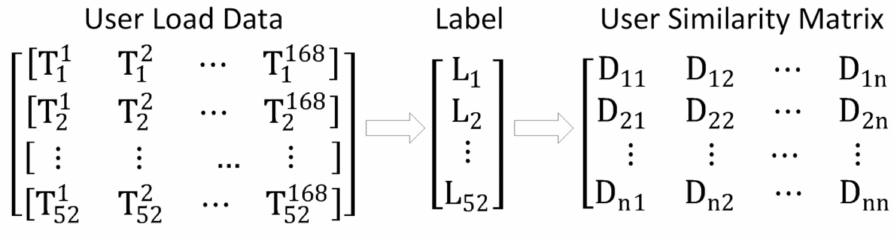
Figure 3. User data conversion process with label generation and similarity matrix calculation.